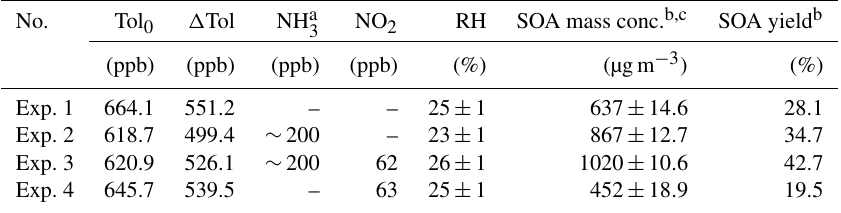
Table 1. Summary of experimental conditions in this study. No. Tol 0 (cid:49) Tol NH a NO 2 RH SOA mass conc. b,c SOA yield b 3 (ppb) (ppb) (ppb) (ppb) (%) (µgm − 3 ) (%) Exp. 1 664.1 551.2 – – 25 ± 1 637 ± 14 . 6 28.1 Exp. 2 618.7 499.4 ∼ 200 – 23 ± 1 867 ± 12 . 7 34.7 Exp. 3 620.9 526.1 ∼ 200 62 26 ± 1 1020 ± 10 . 6 42.7 Exp. 4 645.7 539.5 – 63 25 ± 1 452 ± 18 . 9 19.5 a The concentration of NH b SOA 3 is estimated by the amount of NH 3 added and the volume of the smog chamber. concentration and yield were calculated after taking into account the wall loss. c The reported SOA mass concentrations were the peak values after the wall-loss